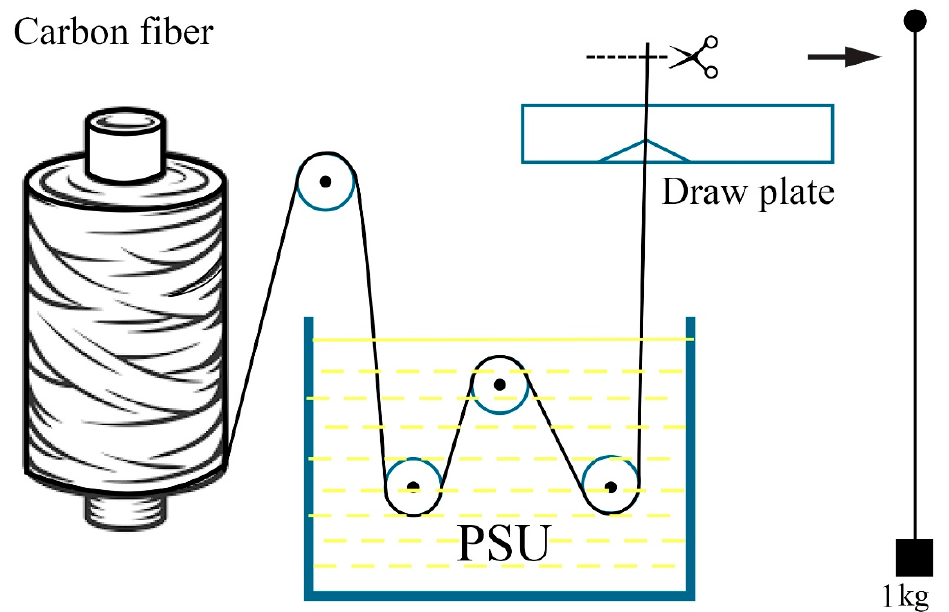
Figure 1. Scheme of impregnation of carbon filaments with a solution of polysulfone and obtaining microcomposites.